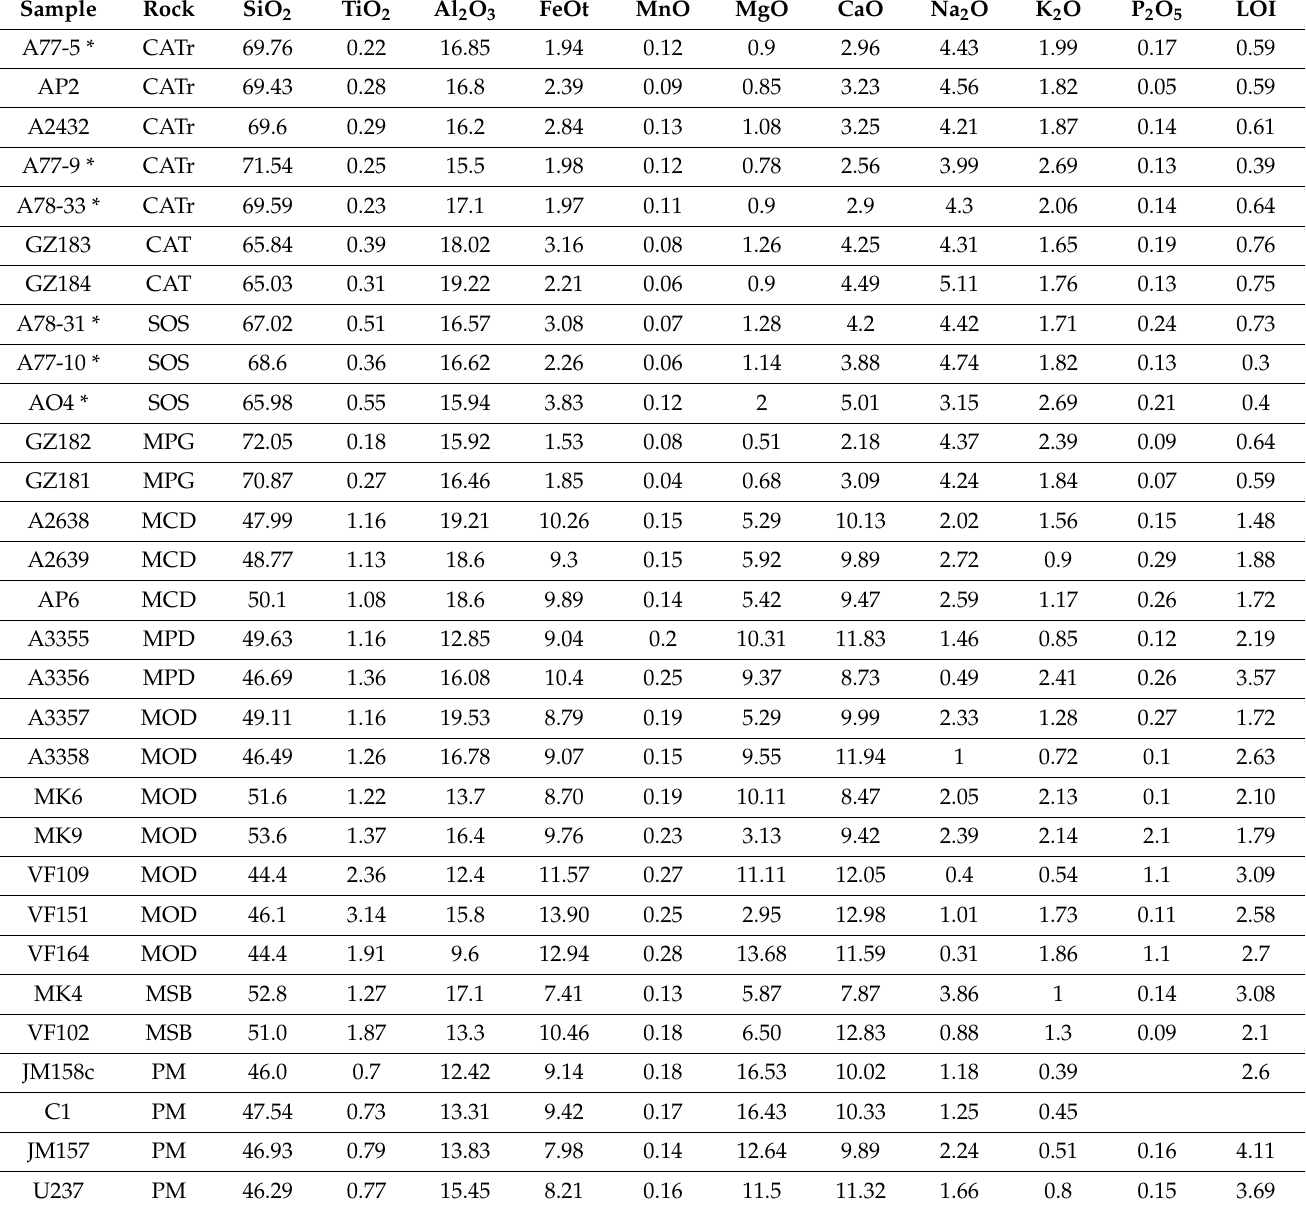
Table 2. Major element compositions of Corno Alto–M. Ospedale samples and Re di Castello Parental Melts (PM) after [16,23,25,31]. Samples marked by * after Macera et al.